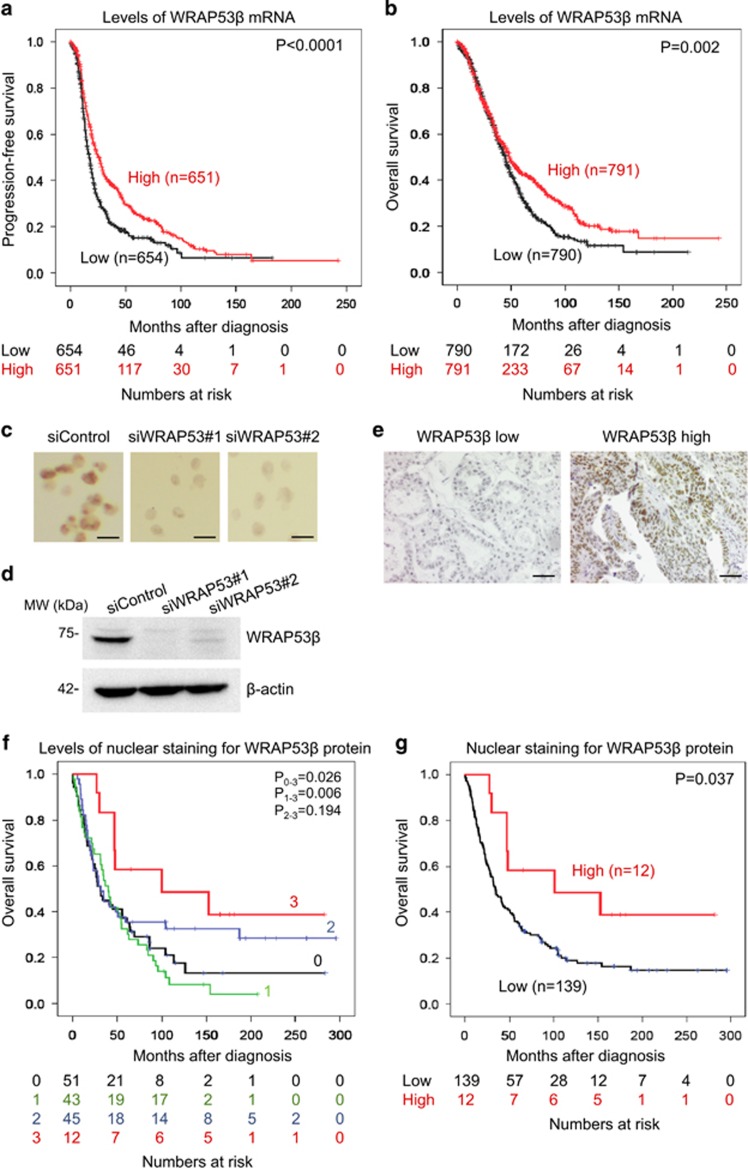
Relationship between the levels of WRAP53β and survival of patients with ovarian cancer. (a) Kaplan-Meier analysis of progression-free and (b) overall survival of patients with epithelial ovarian cancer in relation to the level of WRAP53β mRNA. (c) Immunohistochemical analysis of formalin-fixed and paraffin-embedded U2OS cells transfected with indicated siRNA oligonucleotides for 48 h. Scale bars, 20 μm. (d) Western blotting of WRAP53β and β-actin in U2OS cells treated with the indicated siRNA oligonucleotides for 48 h. (e) Immunohistochemical staining of tumors expressing low and high levels of WRAP53β. Scale bars, 50 μm. (f) Kaplan-Meier analysis of patient survival in relation to the degree of immunohistochemical staining for WRAP53β in the nucleus. Scoring: 0=negative (n=51), 1=weak (n=43), 2=moderate (n=45) and 3=strong (n=12). (g) Kaplan-Meier analysis of the same data as in (f) after grouping of the tumors into those expressing low (0–2) and high (3) nuclear levels of WRAP53β